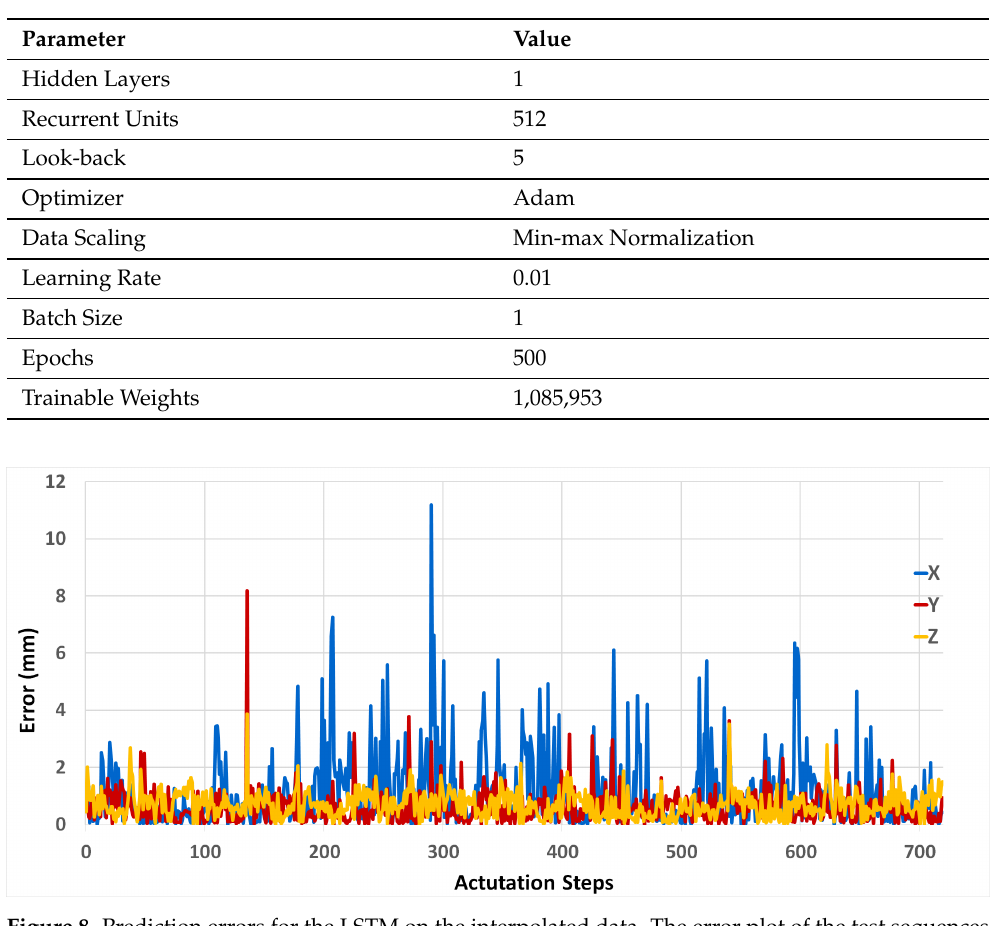
Figure 8. Prediction errors for the LSTM on the interpolated data. The error plot of the test sequences for the 3 motion axes x , y , and z